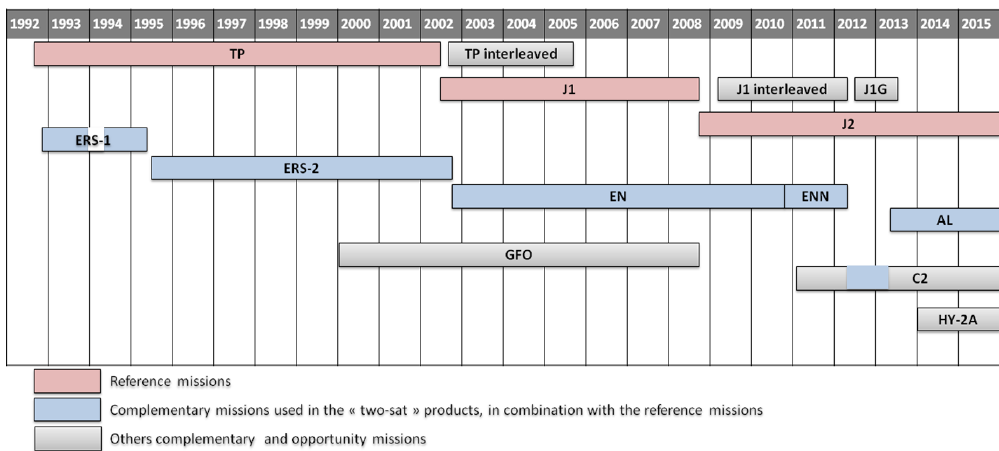
Figure 1. Timeline of the altimeter missions used (or expected) in the multi-mission DUACS DT system.